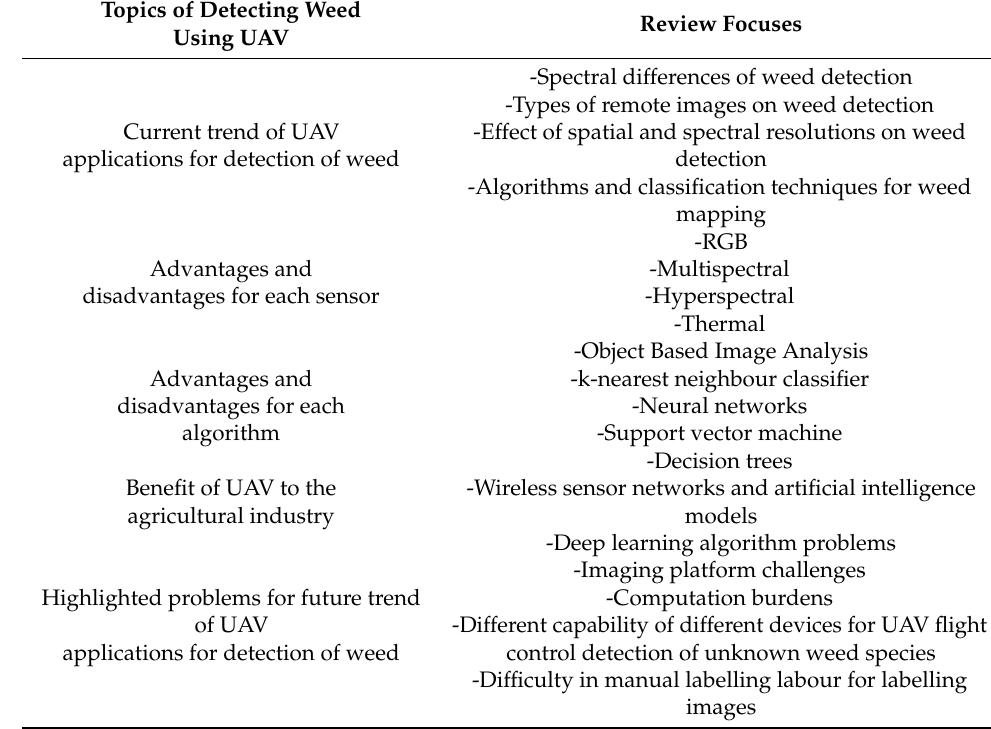
Table 2. Topics reviewed in this